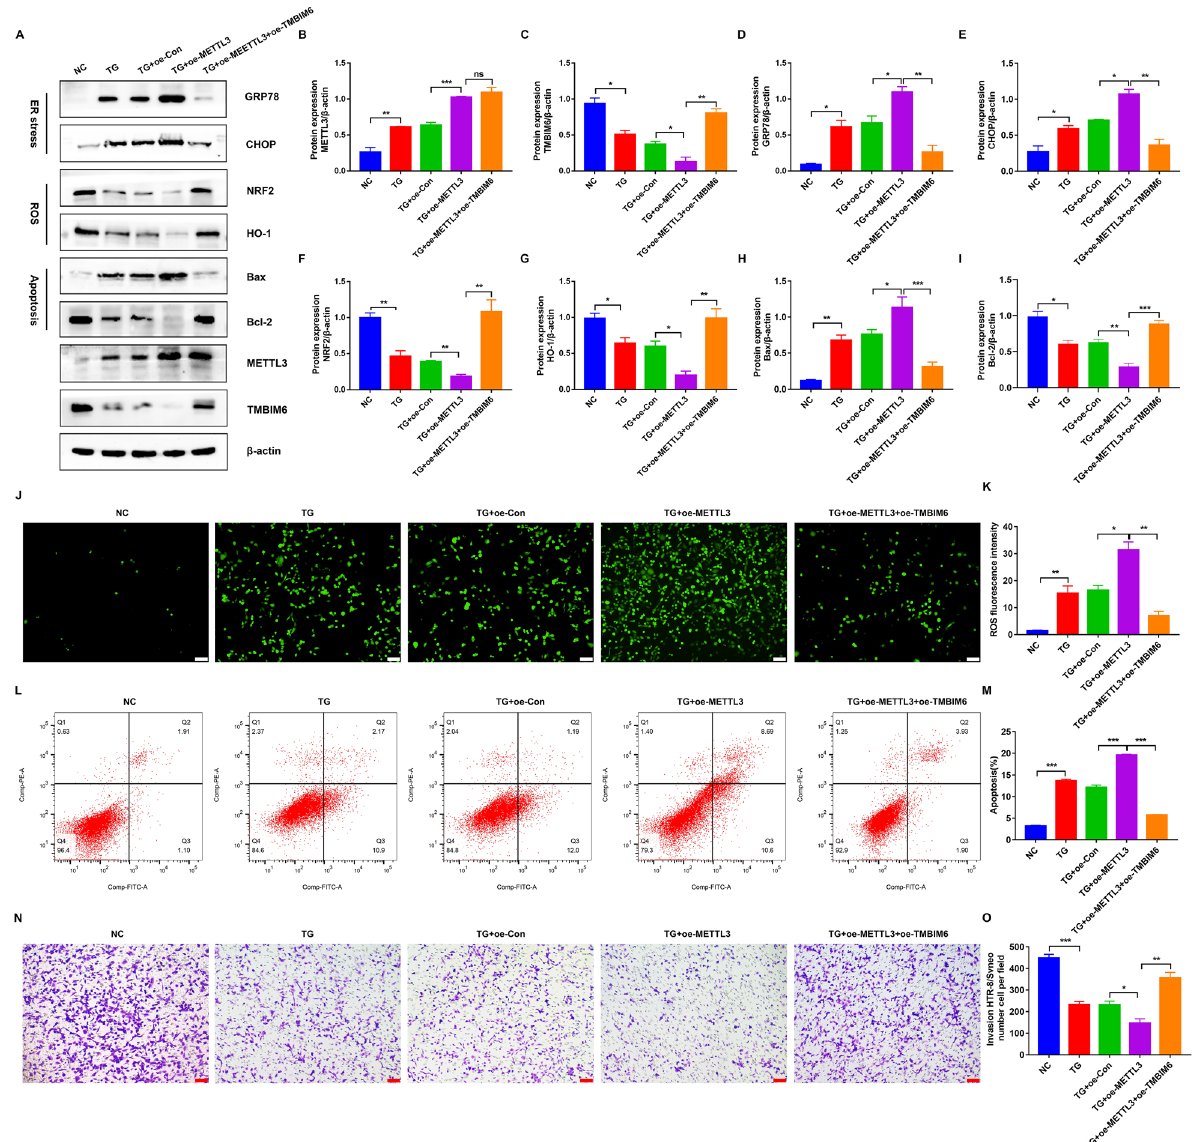
Fig. 6 Overexpression of TMBIM6 partially neutralized the effects of METTL3 on TG-induced ER stress, oxidative stress and apoptosis in HTR-8/SVneo cells. A – I Representative WB images and densitometry quantification of METTL3, TMBIM6, GRP78, CHOP, NRF2, HO-1, Bax and Bcl-2 in different groups. The data were normalized to β-actin. J , K ROS production detected by DCFH-DA. Photographs were obtained at 100 ( Scale bar 100 μm). × L , M Apoptosis rate in different groups detected by flow cytometry. N Representative transwell photos of HTR-8/SVneo cells in different groups (100 magnification, Scale bar 100 μm). O Qualified data shown in L . Oe-Con: Overexpression of control plasmid; Oe-METTL3: Overexpression of × METTL3 plasmid; Oe-TMBIM6: Overexpression of TMBIM6 plasmid. n 3. *p < 0.05, **p < 0.01, ***p < =